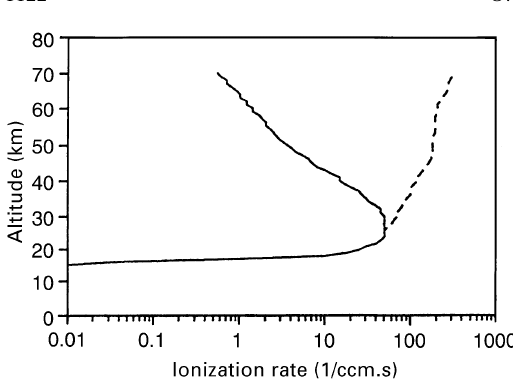
Fig. 6. Ionization rate profiles calculated for GLE event of 16 Feb- ruary 1984 at time of its maximum. Solid curve gives ionization rate profile calculated with geomagnetic cut-off E (cid:49) at 150 MeV, and dashed curve gives ionization rate profile calculated when E (cid:49) "